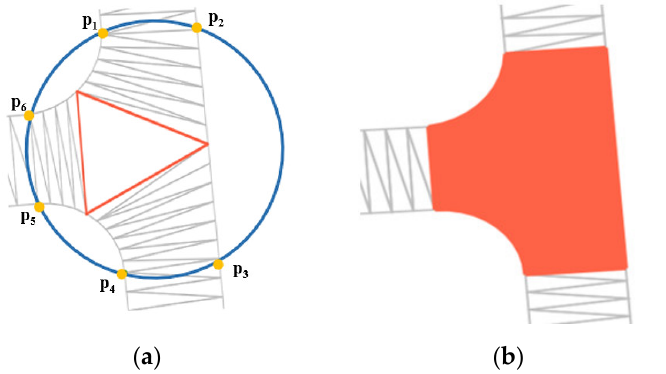
Figure 5. Determination of the intersection area schematic . ( a ) Intersection boundary points; ( b ) Intersection scope.